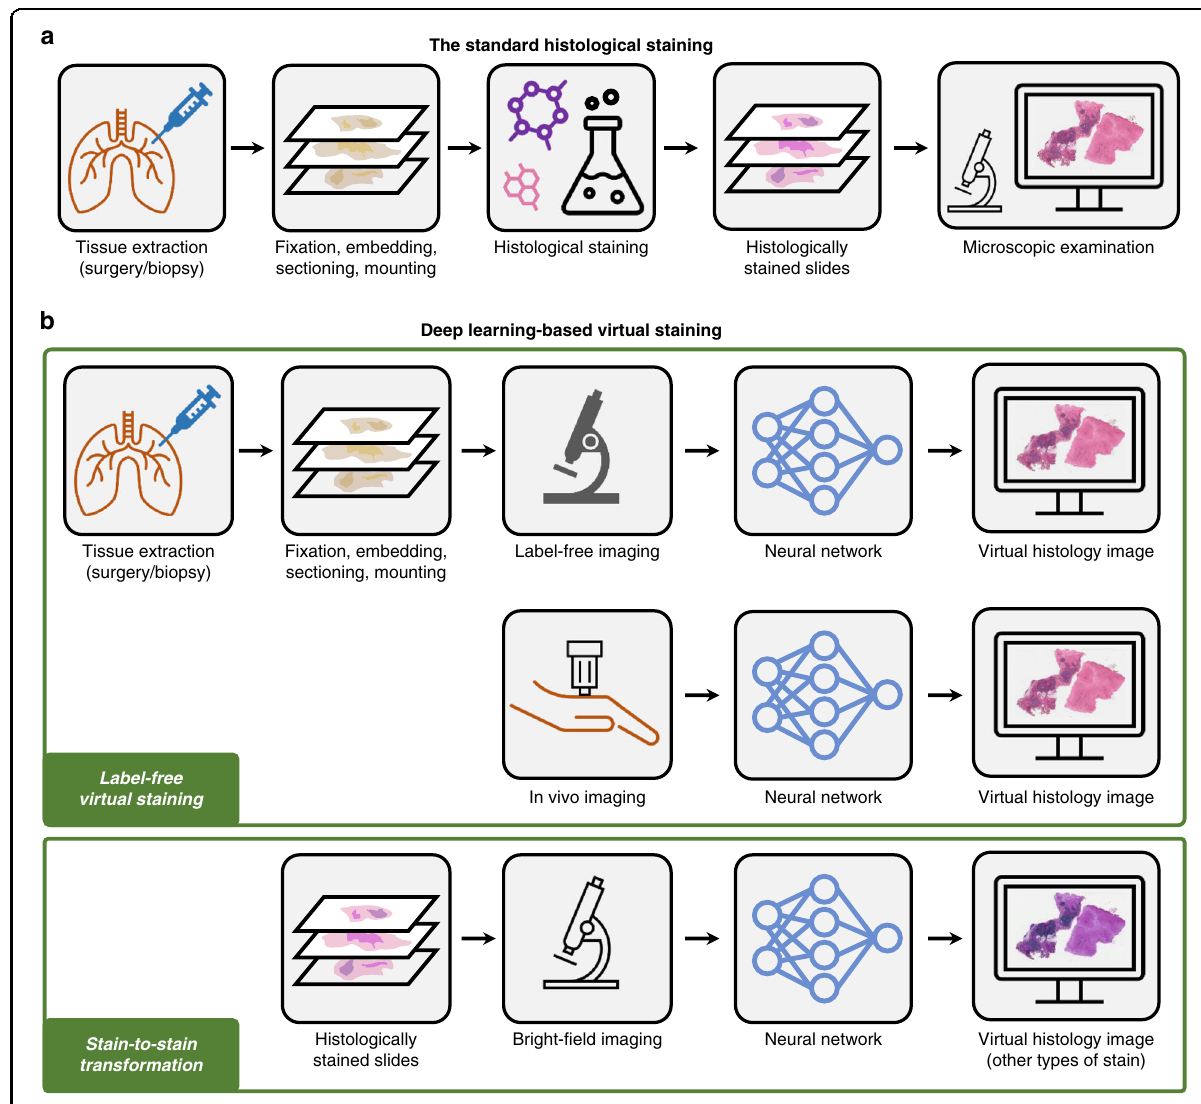
Fig. 1 Schematic of the standard histological staining and deep learning-based virtual staining. a Standard histological staining relies on laborious chemical-based tissue processing and labeling steps. b Pre-trained deep neural networks enable the virtual histological staining of label- free samples as well as the transformation from one stain type to another, without requiring any additional chemical staining